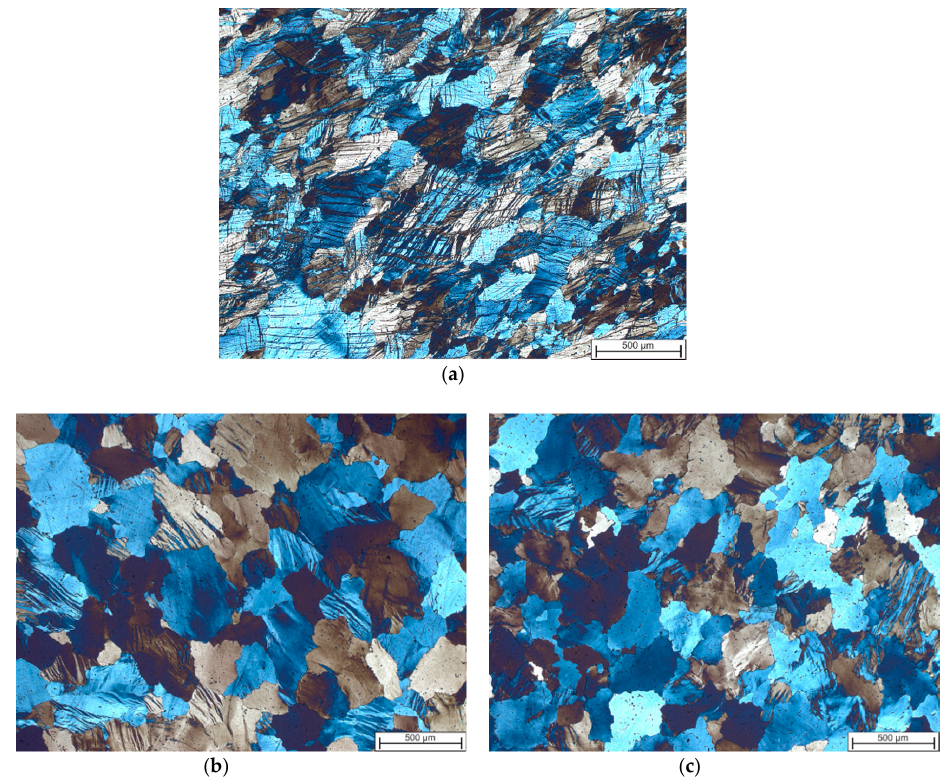
Figure 3. Microstructures of the AlMg5 samples ( a ) ST+ ECAP 2×, ( b ) ST + ECAP 2× + ageing 160 °C for 4 h, and ( c ) ST + ECAP 2× + ageing 180 °C for 4 h.